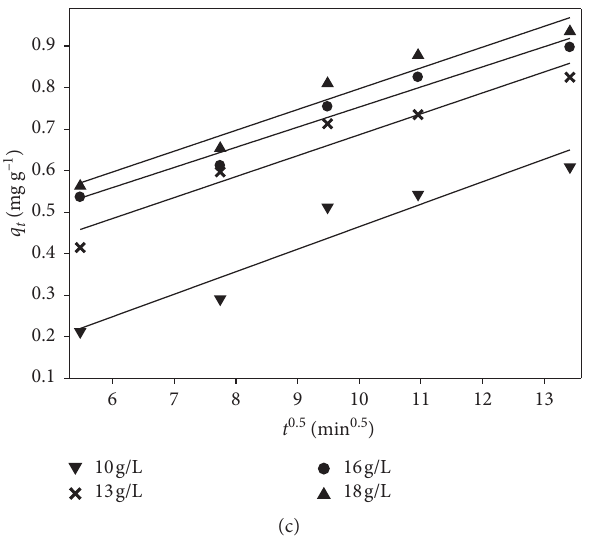
Figure 7: The adsorption kinetics plots for acid red 73 dye adsorption on rice wine